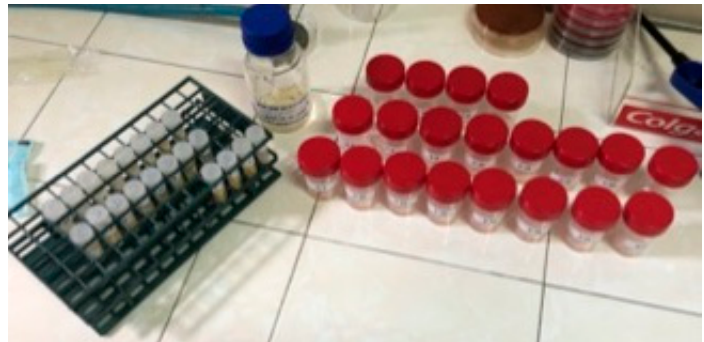
Figure 2. Containers with prepared teeth and metal brackets attached to them, before performing the bacterial inoculation with a 0.2 mL suspension of Streptococcus mutans .